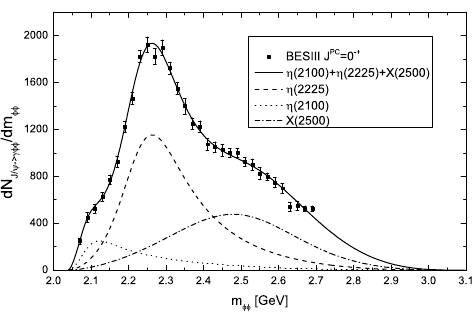
Figure 2. Fitting the 0 − component in the model B.